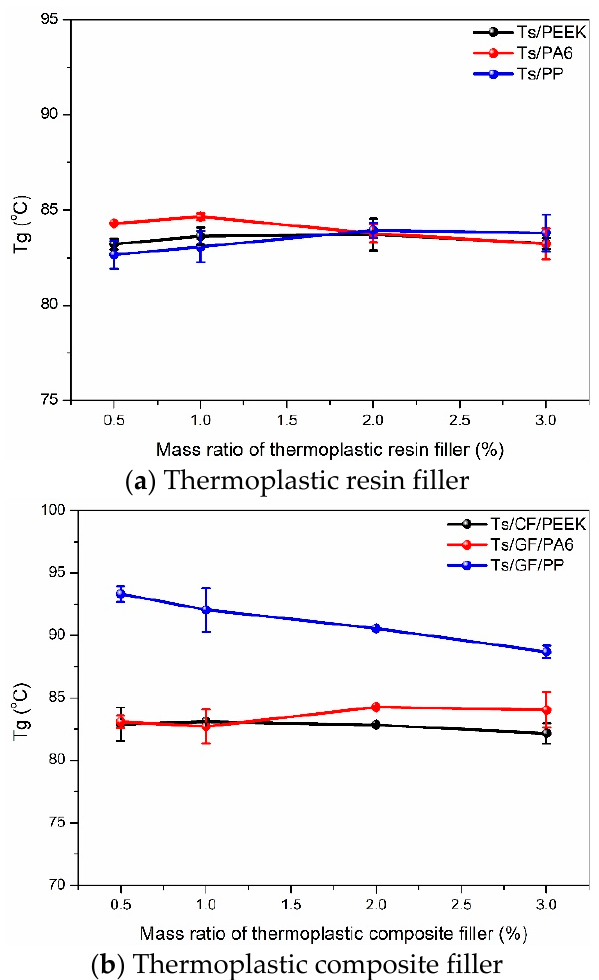
Figure 10. Effects of thermoplastic resin and composite fillers on Tg of Ts resin of ( a ) thermoplastic resin filler and ( b ) thermoplastic composite filler.